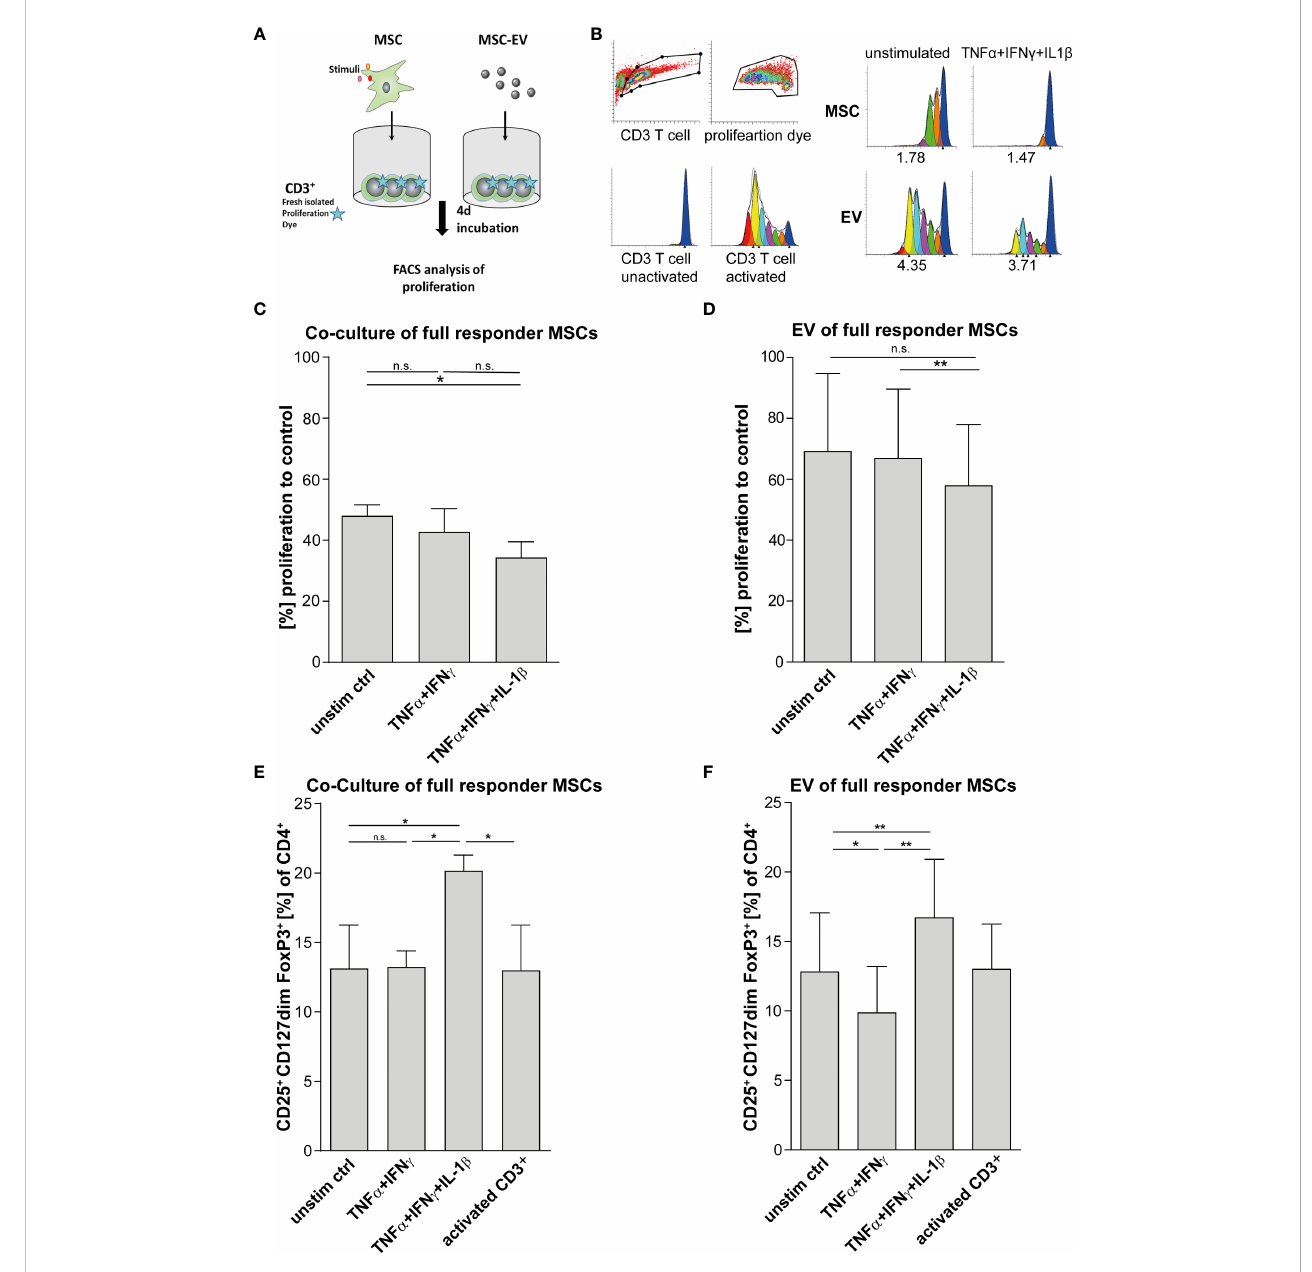
FIGURE 2 T cell effector function is strongly suppressed via direct cell-cell contact and by MSC-EVs after TNF a , IFN g and IL-1 b priming. (A) Schematic overview of CD3 + proliferation assay. MSCs were primed for 24h by TNF a /IFN g or by TNF a /IFN g in combination with IL-1 b , cells were washed and cultured in media for additional 48h. For Tcell proliferation assay, CD3 + repsonder cells were stimulated with T cell-activating tetrameric antibody-complex CD2/CD3/ CD28 and incubated for 4d in the present or absence of different conditioned MSC preparations. (B) CD3 + proliferation measured via dilution of proliferation dye by fl ow cytometry and proliferation index as indicated below was calculated via Mod fi t software. (C) Co-culture of 0.5*10 5 CD3 + and 0.25*10 5 full responder MSCs (CD3 + n = 3), (D) 0.5*10 5 CD3 + incubated with EVs isolated from conditioned media of full responder MSCs (MSC-EV n=3; CD3 + n=3). Paired t-test was used to test statistical signi fi cance (P < 0.05 considered as signi fi cant), data are shown as center value: mean; error bars: SD. (E, F) For Treg induction assays, MSCs were primed for 24h with TNF a and IFN g or TNF a , IFN g and IL-1 b SN, cells were washed and additionally incubated in media for additional 48h. Freshly islolated CD3 + T cells were incubated for 3d with different MSC preperations. T cells were activated with plate bound antibodies CD3 (1mg/mL) and CD28 (2µg/mL). (E) Co-culture of 0.5*10 5 CD3 + T cells and 0.25*10 5 MSCs selected for subsequent in vivo assays (CD3 + n = 3). (F) 0.5*10 5 CD3 + T cells incubated with EV isolated from conditioned media of full responder MSCs (MSC-EV n = 3; CD3 + n = 3). Frequency of Tregs was detected by fl ow cytometry with MFI marker expression of CD4 + CD127 dim CD25 + FOXP3 + of total CD4 + . Paired t-test was used to test statistical signi fi cance (p < 0.05 considered as signi fi cant). Data are shown as center value: mean; error bars: SD. ns, not signi fi